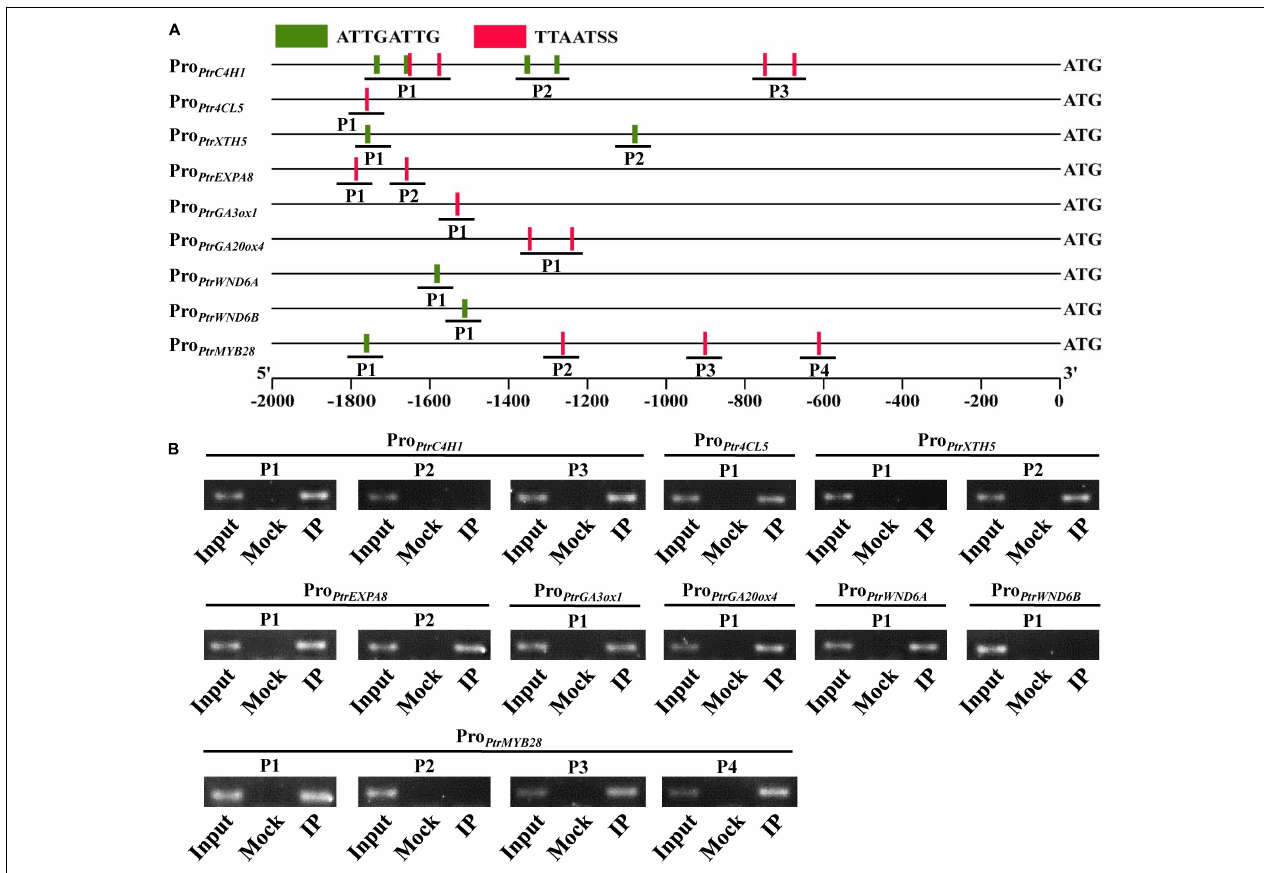
FIGURE 8 | PtrWOX13A directly binds to the promoters of the poplar transcription factors and secondary cell wall biosynthesis pathway genes. (A) Schematic diagrams of the promoters showing the locations amplified by ChIP-PCR. (B) ChIP-PCR analysis of the promoter fragments enriched due to PtrWOX13A binding during immunoprecipitation; 30-day-old poplar plants overexpressing PtrWOX13A-Flag used for ChIP with anti-Flag antibodies. Input, Mock, and IP indicate the chromatin before immunoprecipitation (IP), IP with no antibodies, and IP with anti-FLAG antibodies, respectively. Those genes include lignin biosynthesis genes ( PtrC4H1 and Ptr4CL5 ), fiber cell elongation genes ( PtrXTH5 and PtrEXPA8 ), GA biosynthesis genes ( PtrGA20ox4 and PtrGA3ox1 ), and TFs ( PtrWND6A , PtrWND6B , and PtrMYB28 ).